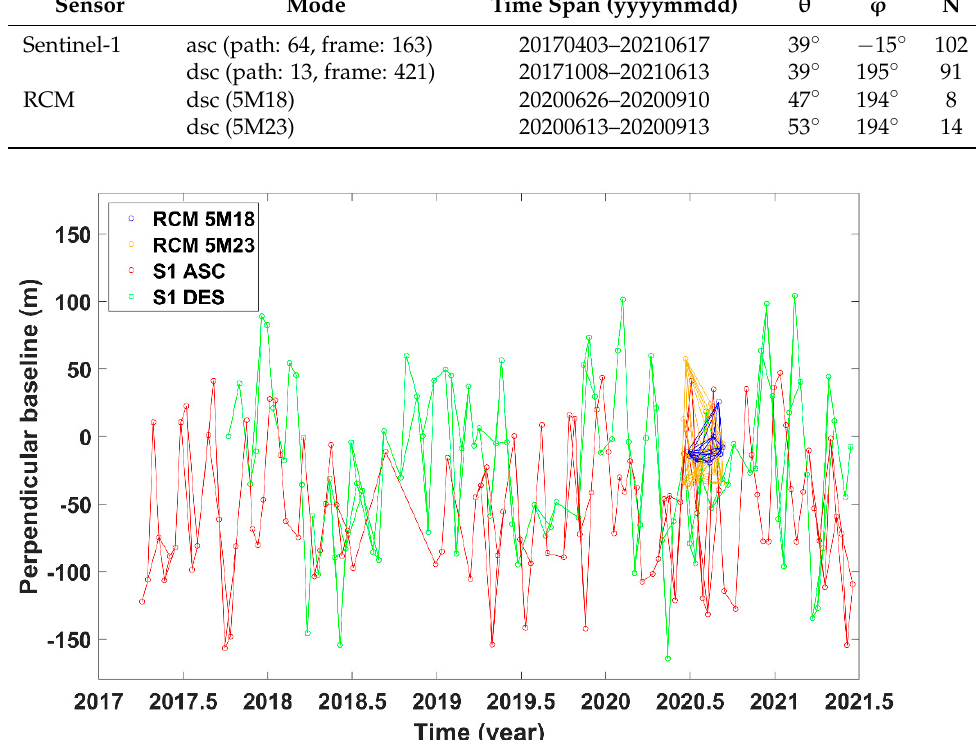
Figure 2. Perpendicular baselines of Sentinel-1 (S1 ASC: ascending, S1 DES: descending) and RCM (RCM 5M18: descending 5M18 mode, RCM 5M23: descending 5M23 mode) InSAR pairs (red: Sentinel-1 ascending, green: Sentinel-1 descending, blue: RCM descending 5M18 mode, yellow: RCM descending 5M23 mode).